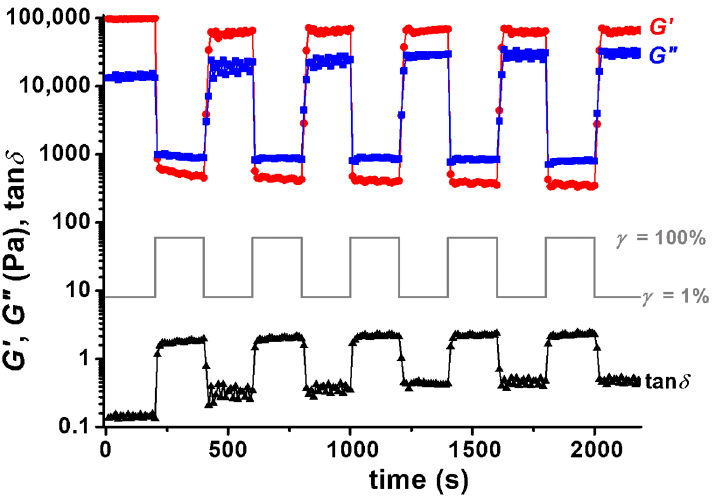
Figure 6. Self-healing test for the hydrogel containing 13% ( w / v ) Plx- g -CMP by following the evolution of the viscoelastic parameters in time, when two successive levels of deformations were applied each for 200 s: 1% and 100% (37 °C, 1 rad/s).